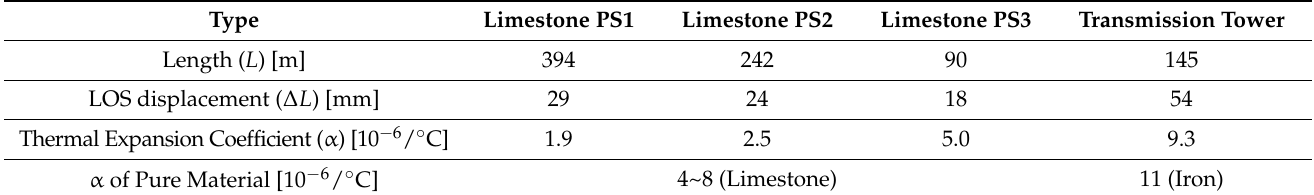
Table 4. Calculation of the thermal expansion coefficients of exposed limestone rocks and the transmission iron tower.